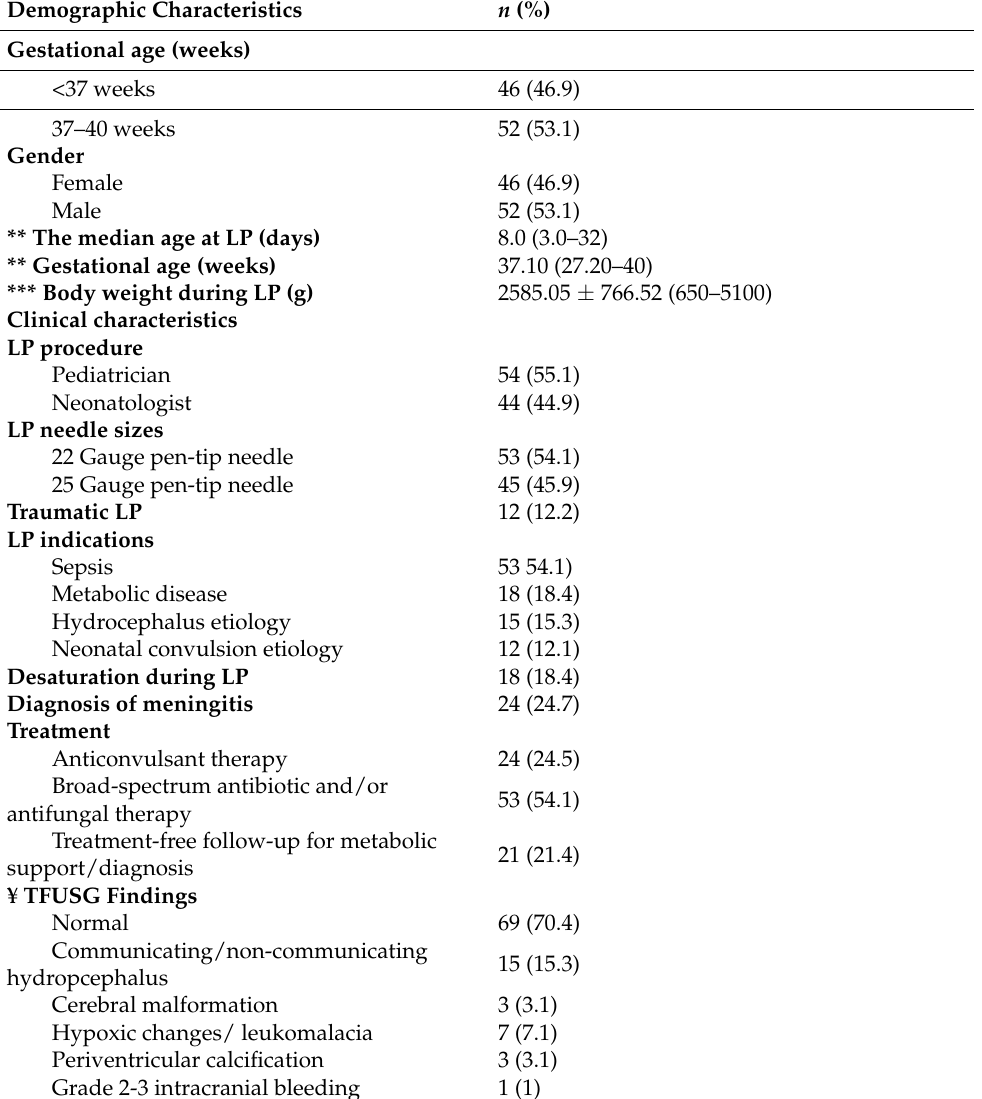
Table 1. Clinical and demographic characteristics of the patients who underwent LP